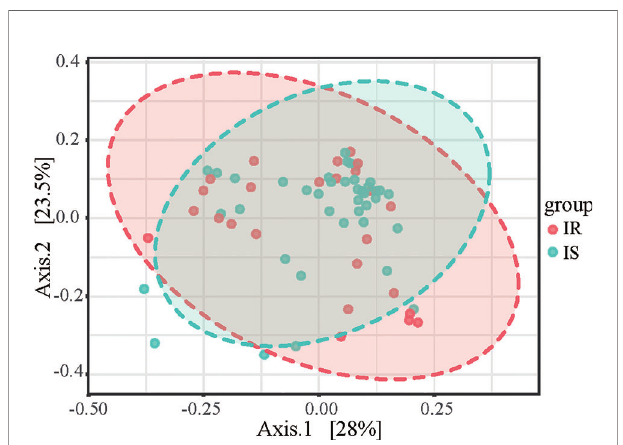
FIGURE 2 | Principal coordinates analysis (PCoA) plot of IR and IS subjects. The plots show the fi rst two principal coordinates (axes) for PCoA using the Bray-Curtis Distance method.